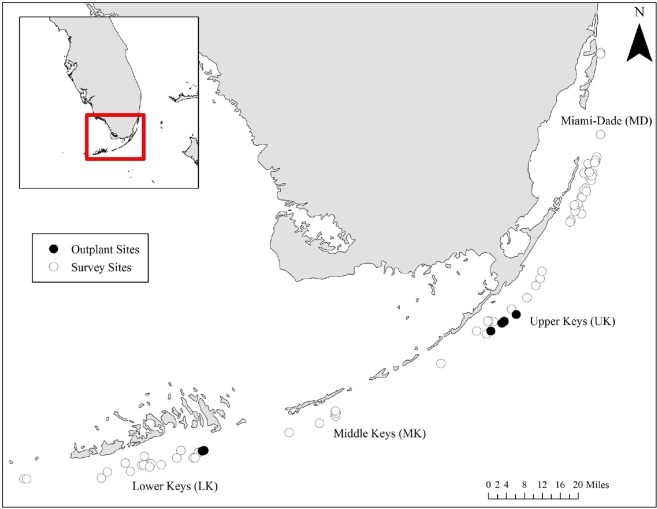
Location of sites along the Florida Reef Tract surveyed to investigate damselfish occupational dynamics and impacts.Open circles indicate sites where only wild staghorn colonies were observed. Black circles indicate sites where nursery-grown colonies were outplanted as part of restoration activities.